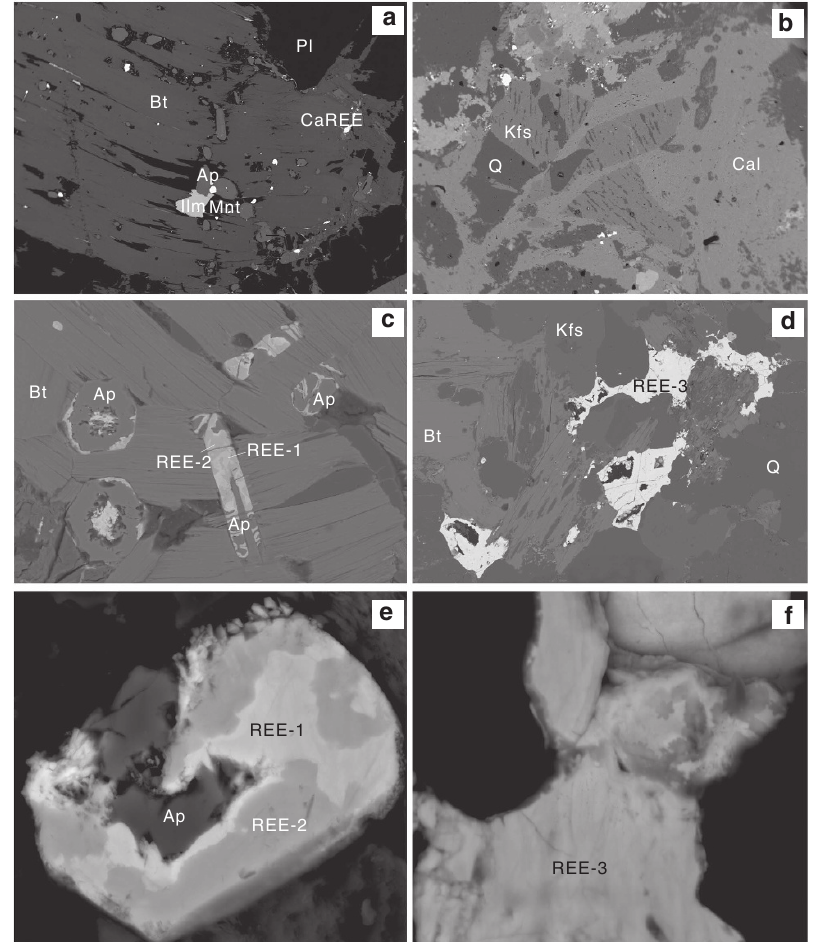
Figure 2 | Selected characteristic textures observed in the granites. ( a ) Primary REE minerals including Ca-REE fluorcarbonate (Ca-REE) and monazite- (Ce) (Mnt) associated with fluorapatite (Ap) and ilmenite (Ilm) in biotite (Bt). ( b ) Sr-rich calcite (Cal) inter-grown with K-feldspar (Kfs) and quartz (Q). ( c ) fluorapatite altered to produce REE phosphate minerals REE-1 and REE-2, which contain high HREE and Ce-poor compositions. ( d ) anhedral interstitial REE fluorcarbonate (REE-3) with high HREE and low Ce abundances. ( e , f ) high magnification images of the unidentified REE minerals. Pl, plagioclase. Field of view: ( a ) 3mm; ( b ) 2.5mm; ( c ) 0.15mm; ( d ) 1.5mm; ( e , f ) 30 m